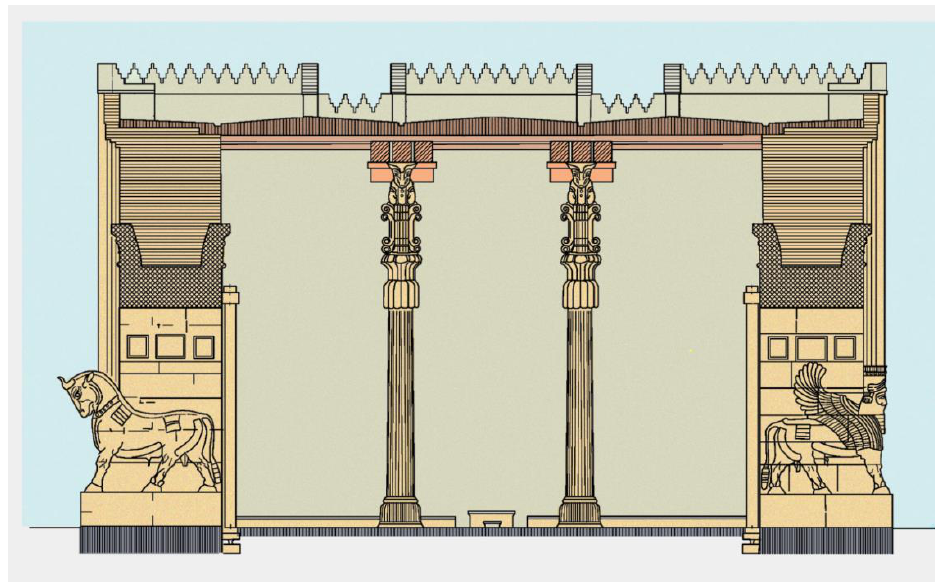
Figure 4. The addorsed bull capitals are oriented towards north-south direction in Krefter’s reconstruction designs. Based on: [19] (Beilage 2). CAD redrawing and coloring by the author.